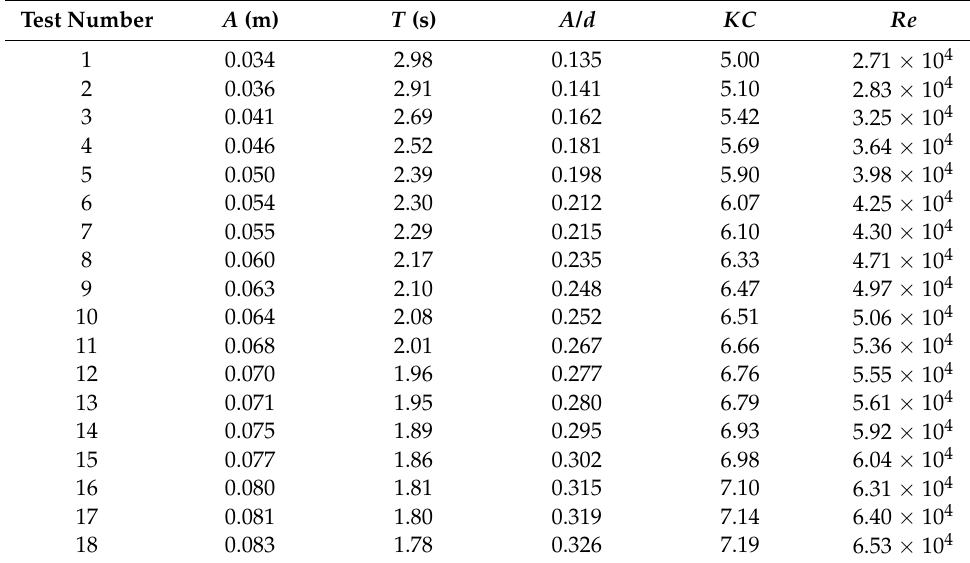
Table 1. Main characteristics of the experimental